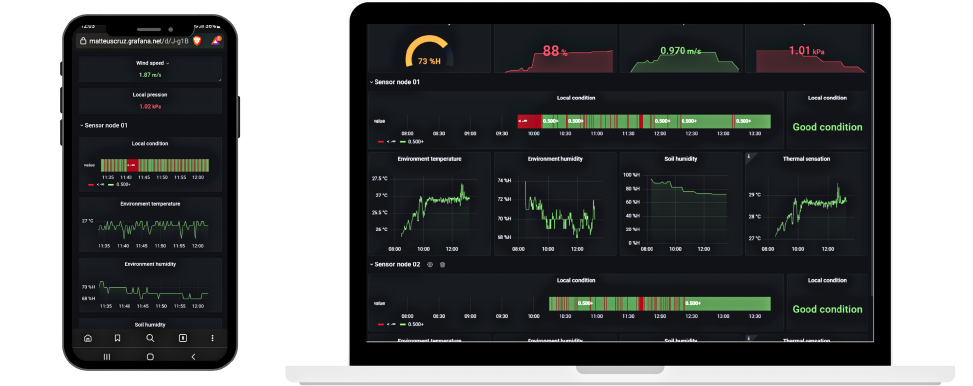
Figure 8. Grafana dashboard interface captured from the smartphone and